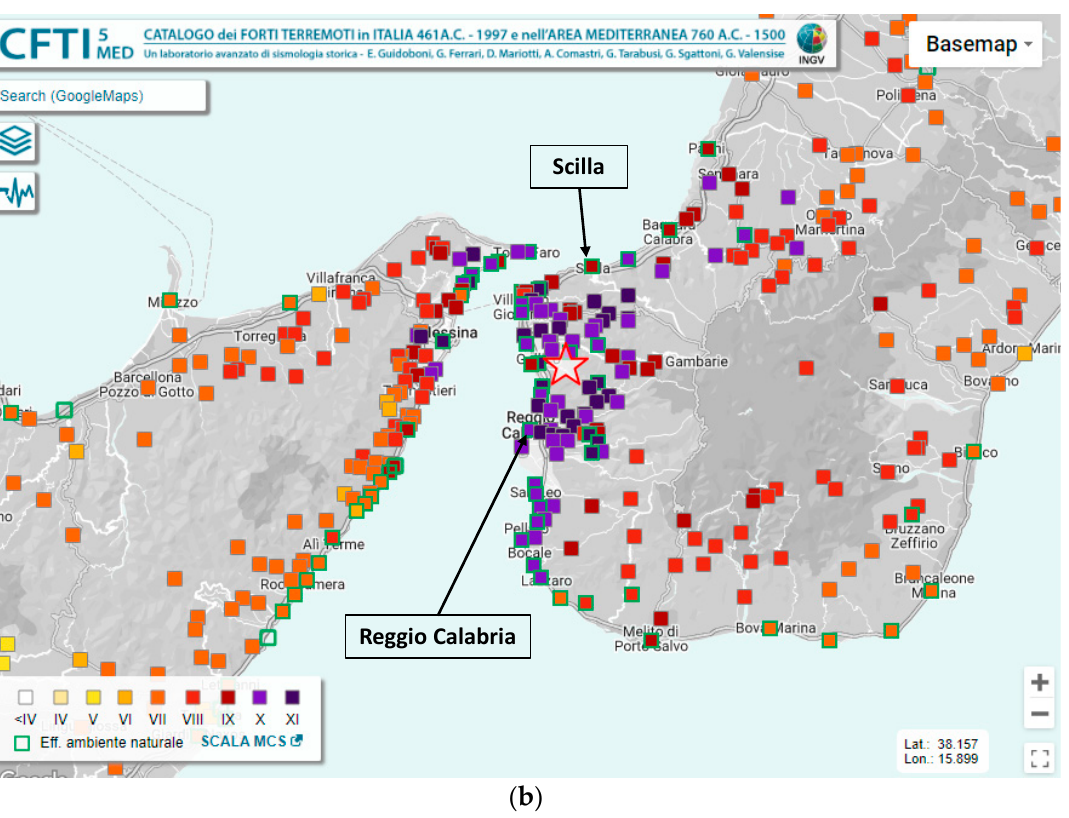
Figure 2. ( a ) Chronology of earthquakes in Reggio Calabria region; ( b ) shake map concerning MCS macorseismic intensity scale of 1908 Messina and Reggio earthquake (source: ICSE by INGV).